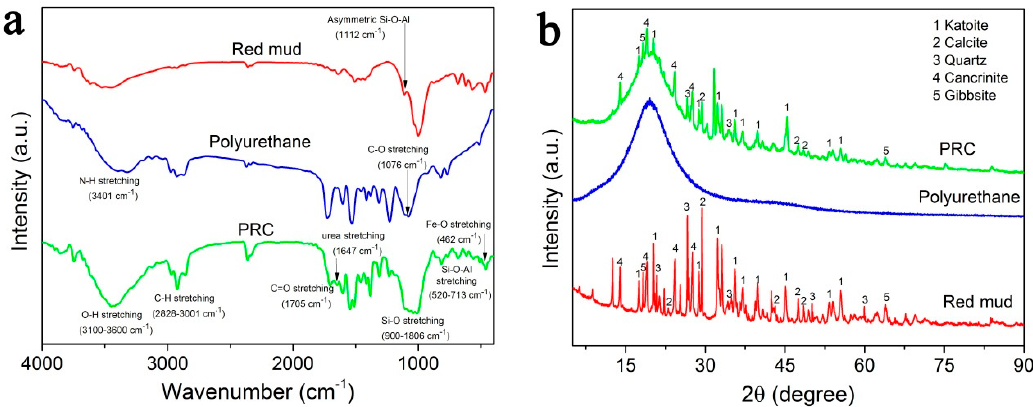
Figure 4. FTIR ( a ) spectra and XRD ( b ) patterns of red mud, polyurethane and PRC.